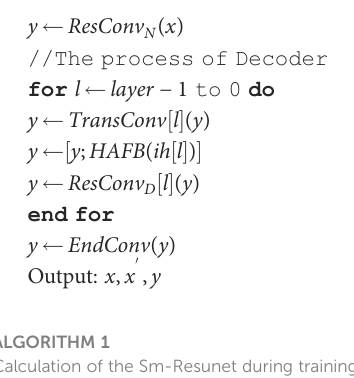
ALGORITHM 1 Calculation of the Sm-Resunet during